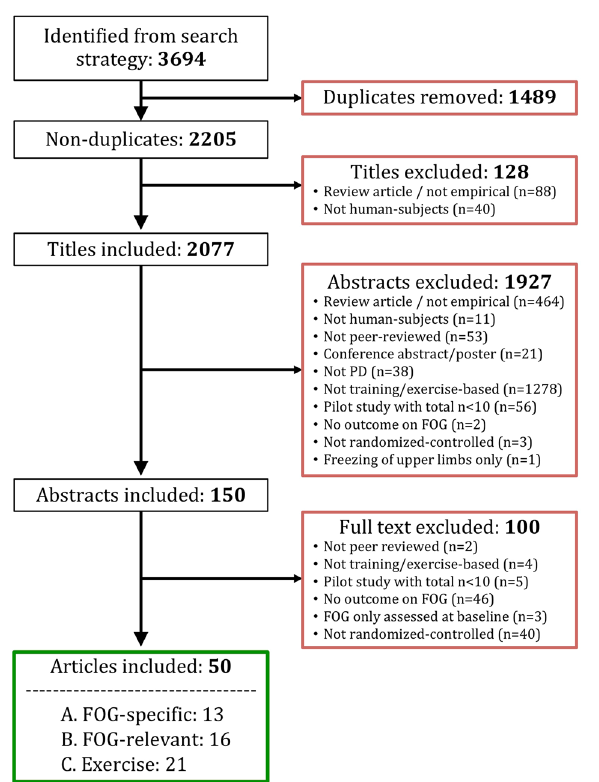
Fig. 2 Flowchart of the systematic article selection strategy. From 3694 articles identi fi ed from the search strategy, a total of 50 articles were included for review. Red boxes indicate exclusions of articles during each of the following screening stages: duplicate removal, title, abstract, full-text. Reasons for exclusion are shown inside the red boxes. Green box indicates